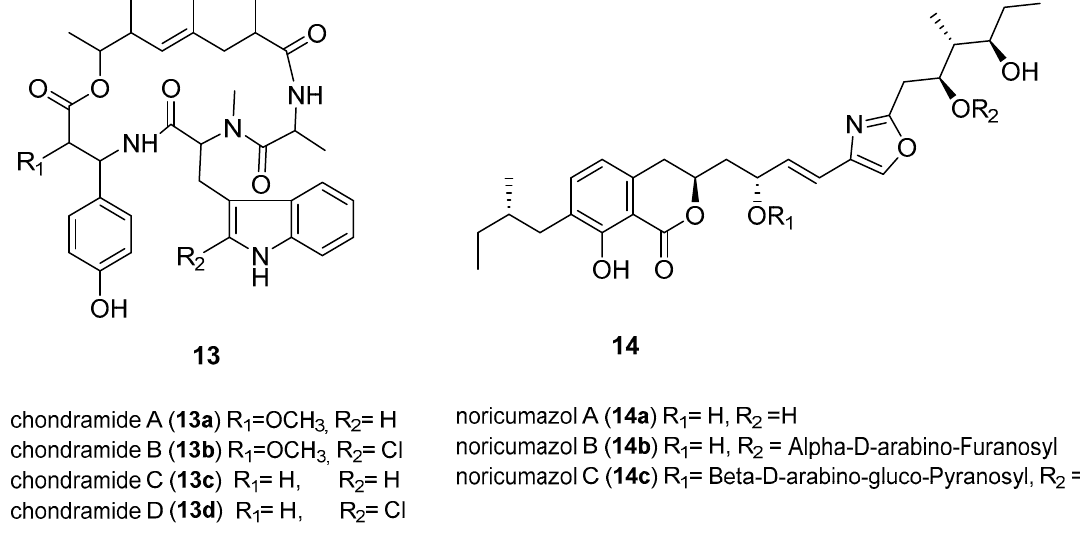
Figure 5. Structures of myxobacterial-derived compounds with activity against Ebola virus (EBOV). Chondramides ( 13a – d ) are known to be actin inhibitors, while noricumazols ( 14a – c ) are known potassium channel inhibitors [70,71].